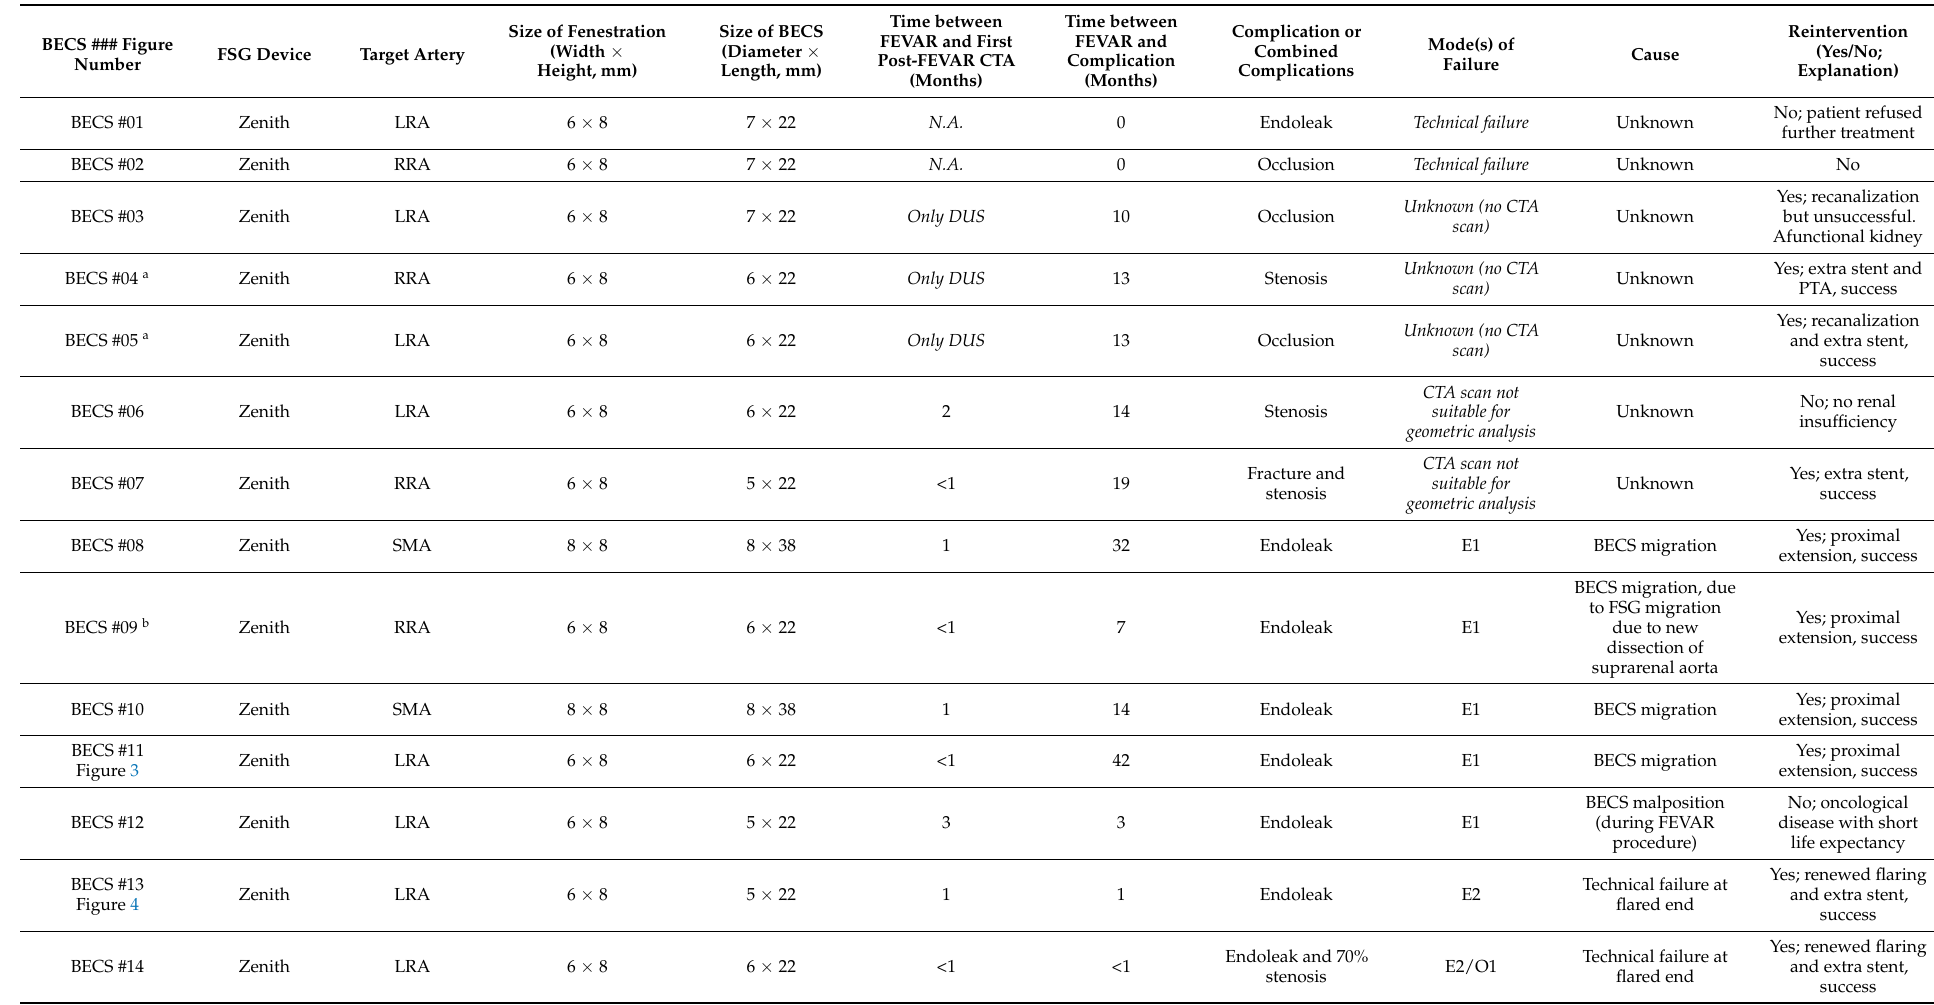
Table 1. Overview of studied variables per Advanta V12 balloon-expandable covered stent (BECS) with complicated